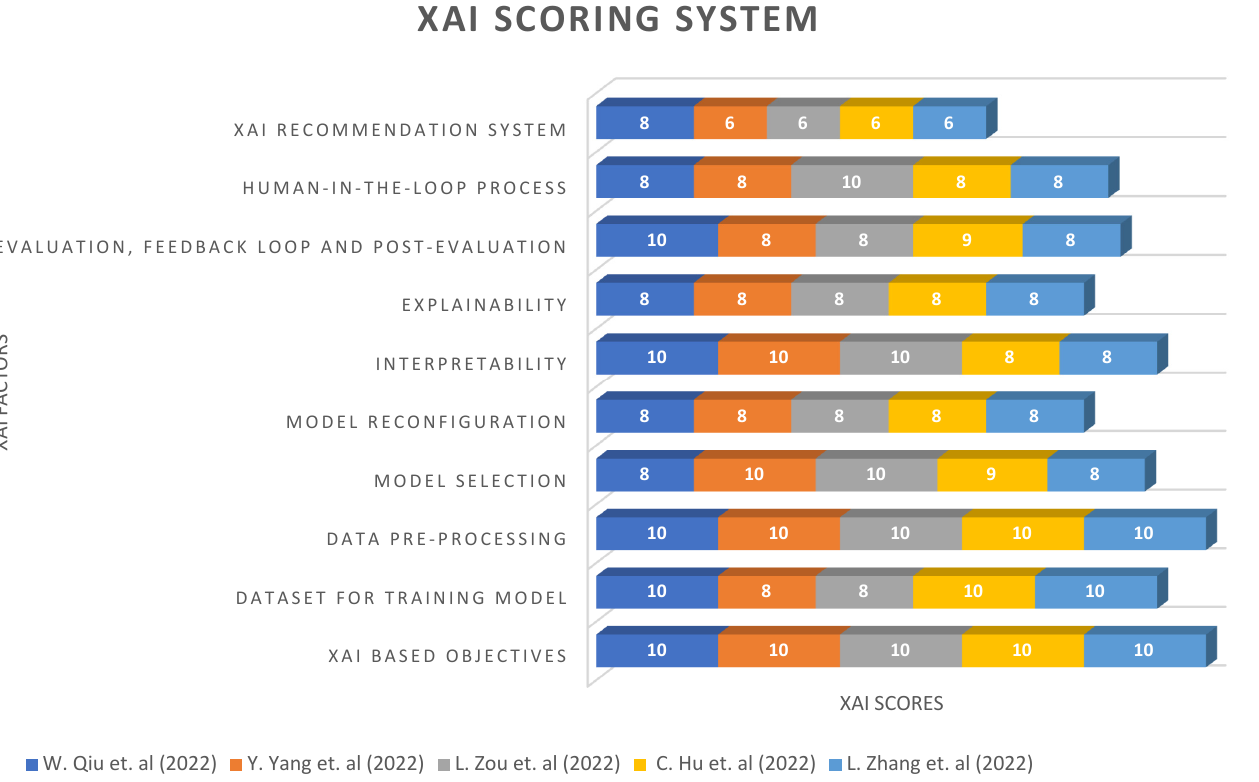
Figure 11. XAI Scoring System Evaluation.